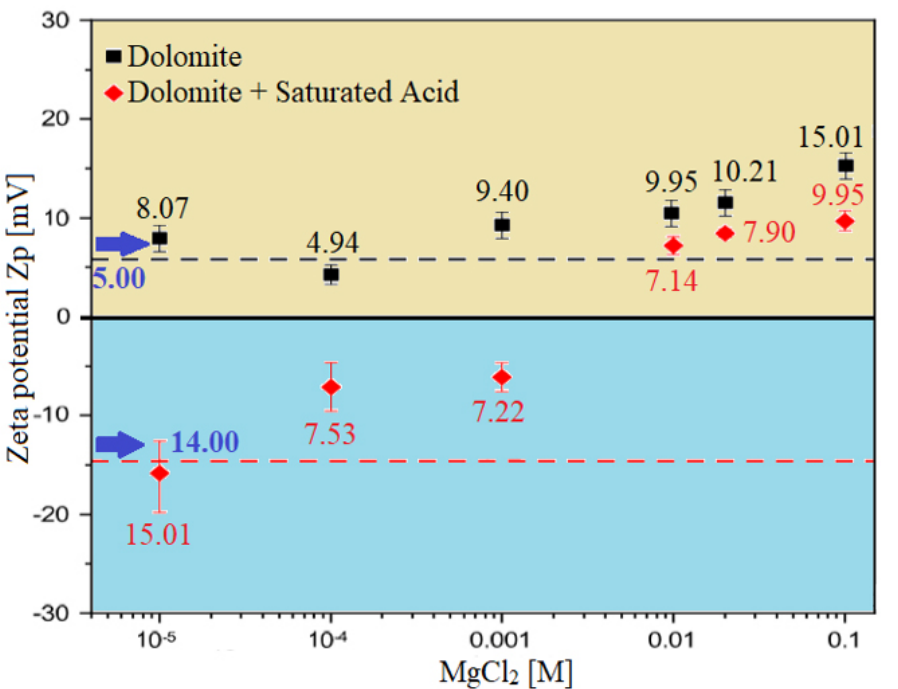
Figure 25. Zeta Potential (ZP) of dolomite carbonate rocks/brine interface; It shows the effect of brine solutions containing divalent ions (MgCl 2 ) on the behaviour of surface charge alteration on dolomite rock